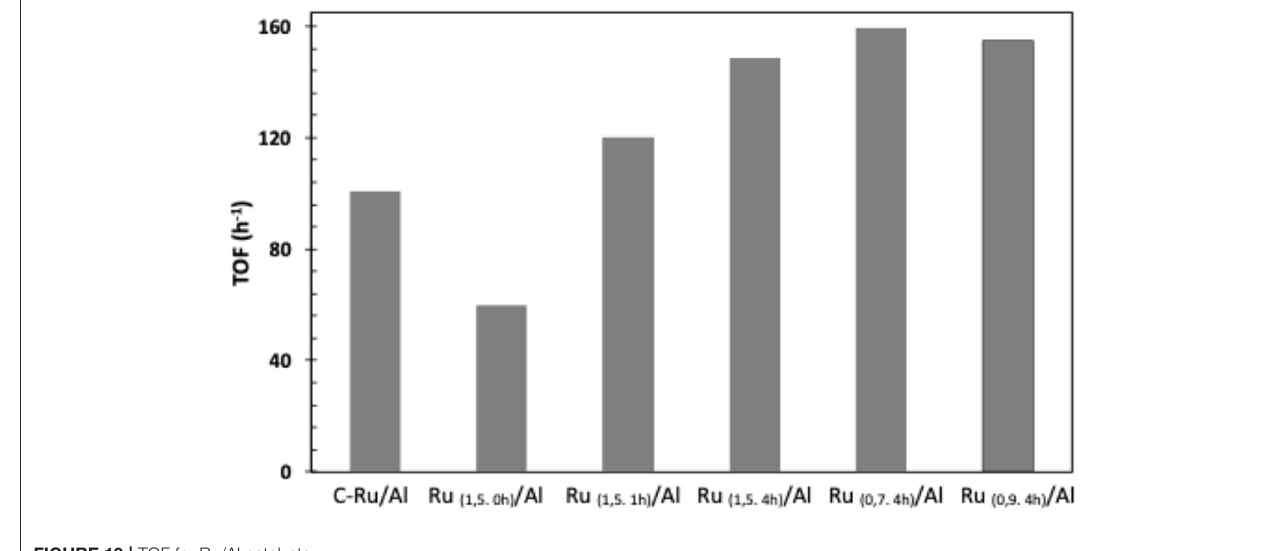
Frontiers in Chemistry |